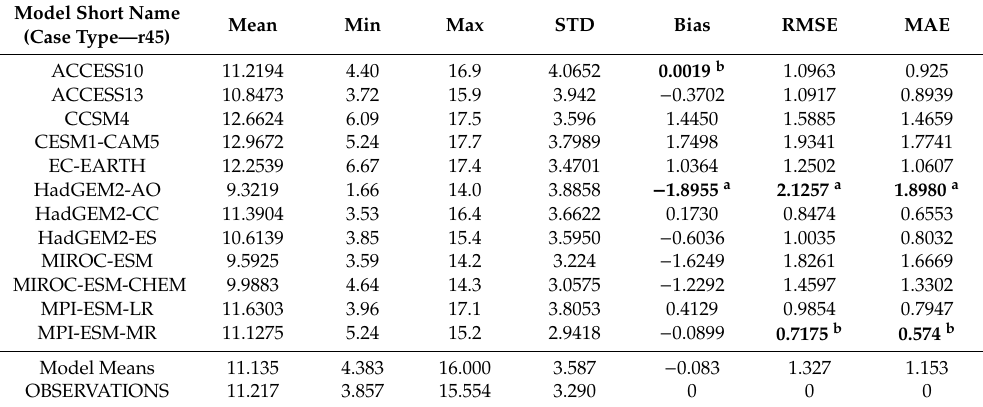
Table 3. Statistics of SIE time series of climate model projections for the scenario RCP4.5 (r45) for 2006–2017. The basic statistics of the model means and observed SIE time series are also included in the last two rows for reference. Units are 10 6 km 2 . The bias, RMSE, and MAEs of model simulated SIEs that used the satellite data are listed in the last three columns. The values in bold under the Bias, RMSE, and MAE columns denote the maximum magnitudes (not absolute values; superscript a) and the minimum magnitudes (superscript b) amongst all values in the column.